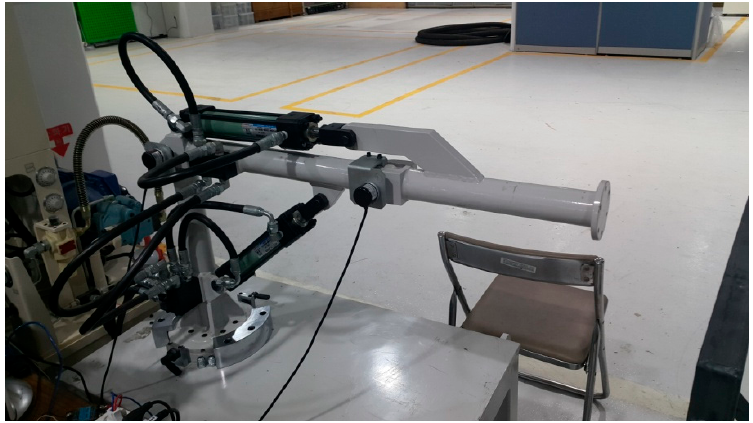
Figure 1. Hydraulic robot manipulator.